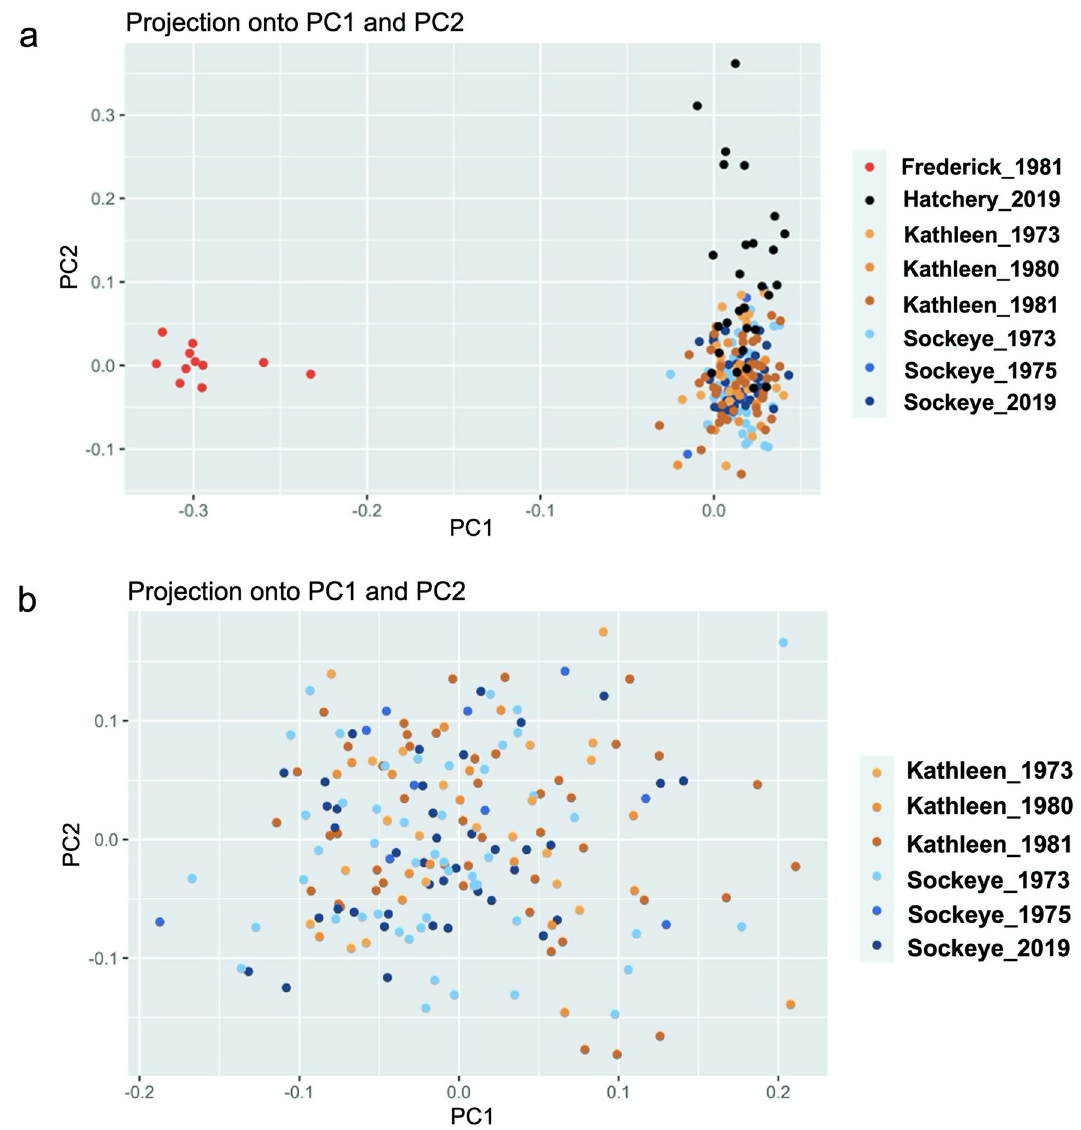
Figure 3. ( a ) PCA for individuals in Sockeye Lake, Kathleen Lake, Frederick Lake, and the Whitehorse Rapids Fish Hatchery (neutral, 271 SNPs) (PC1 = 12.5%, PC2 = 3.7%, genetic variation explained), showing a clear separation of Frederick Lake individuals and a partial separation of hatchery individuals from KNPR individuals. ( b ) PCA for individuals in Sockeye and Kathleen Lakes (neutral, 271 SNPs) (PC1 = 2.9%, PC2 = 2.7%, genetic variation explained) revealing no clear clustering by year or